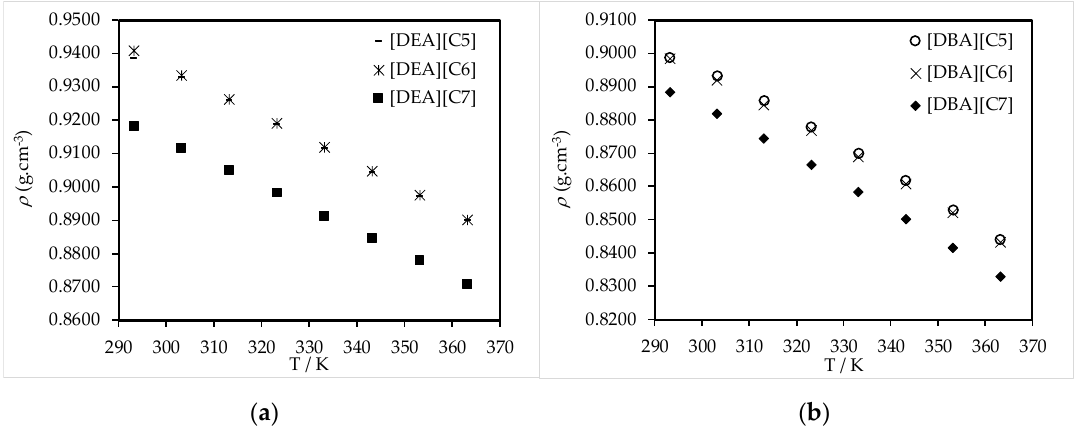
Figure 1. ( a ) Density ( ρ ) values of diethylammonium pentanoate [DEA][C5], diethylammonium hexanoate [DEA][C6], and diethylammonium heptanoate [DEA][C7] as a function of temperature. ( b ) Density ( ρ ) values of dibutylammonium pentanoate [DBA][C5], dibutylammonium hexanoate